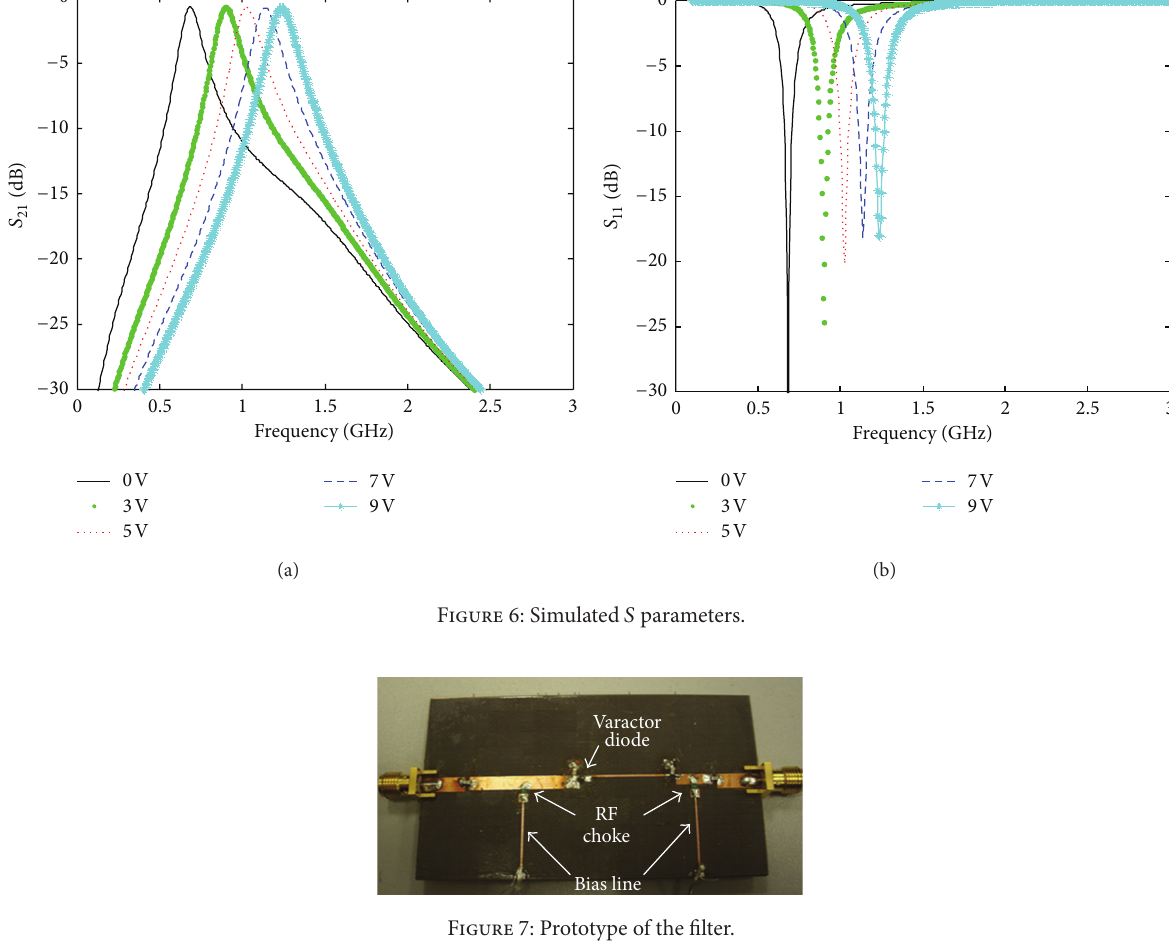
Figure 7: Prototype of the filter.